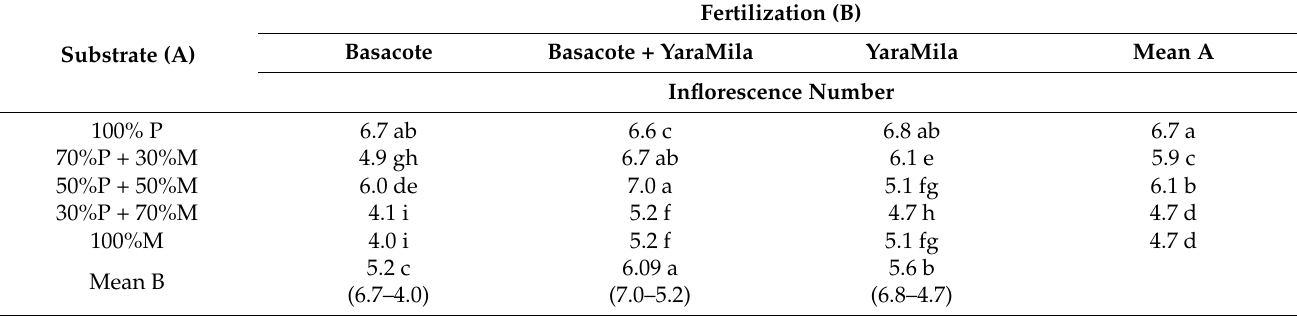
Table 3. Flowering of Sedum spectabile ‘Stardust’ grown in containers with five different